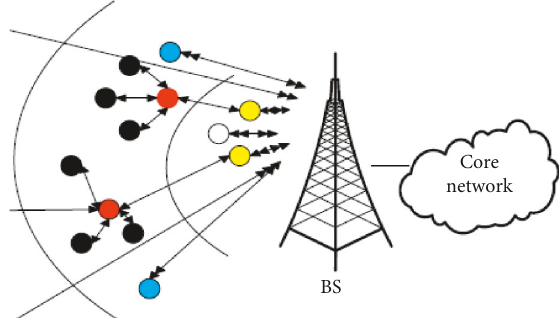
Figure 1: Head cluster users (red points: primary users and black points: secondary